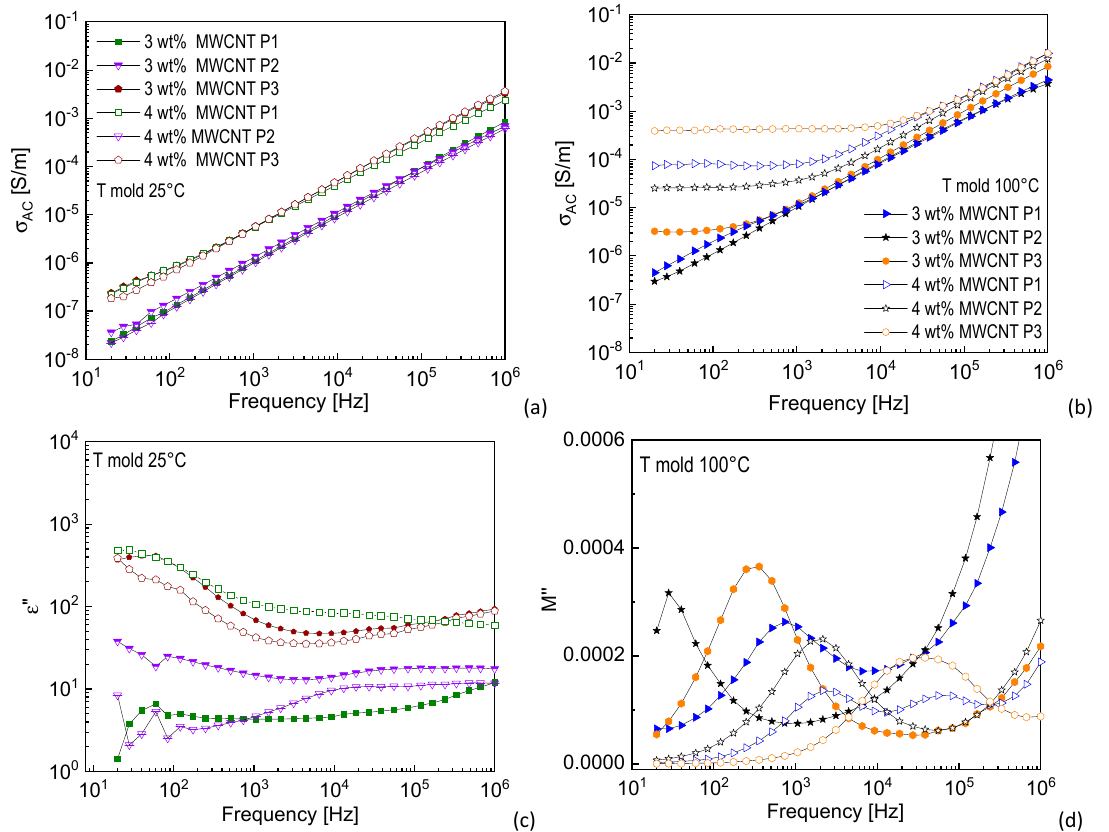
Figure 4. ( a,b ) σ AC curves of 3 and 4 wt%-MWCNT nanocomposites manufactured at mold temperatures ( a ) 25 ◦ C and ( b ) 100 ◦ C. ( c , d ) M” curves of 3 and 4 wt%-MWCNT nanocomposites manufactured at mold temperatures ( c ) 25 ◦ C and ( d ) 100 ◦ C (graph legend reported in ( a ) is valid also for ( c ); graph legend reported in ( b ) is valid also for ( d